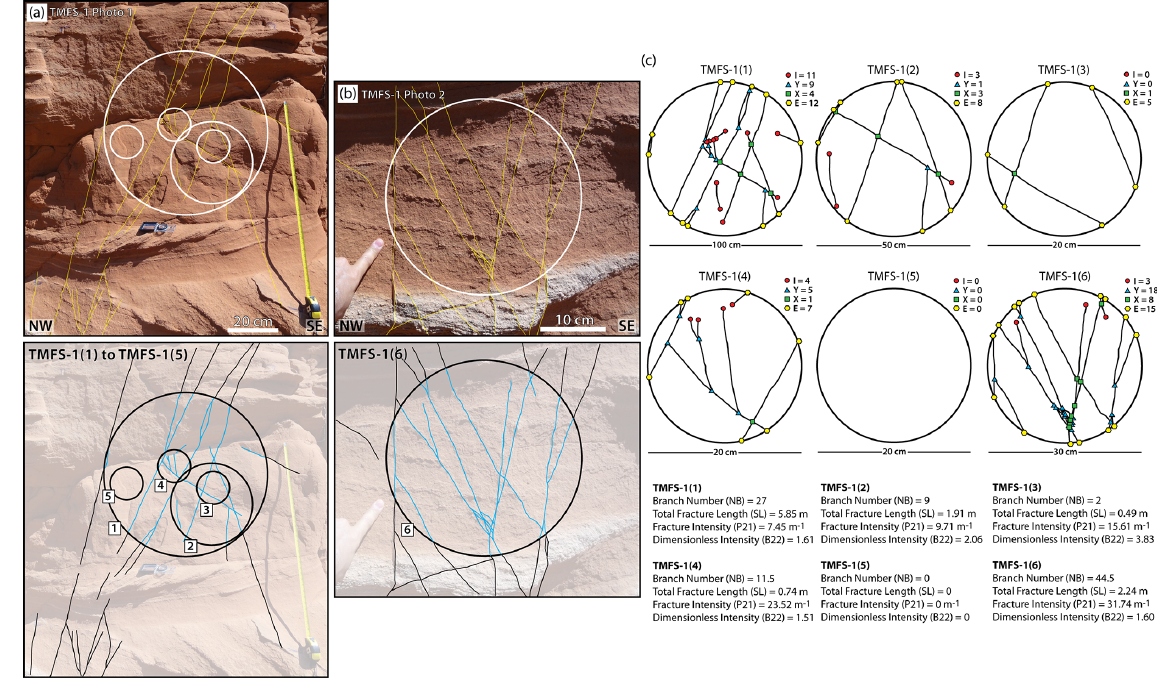
Figure A1. Sample station TMFS-1 scan circles (a, b) and nodal analysis (c) with statistics.